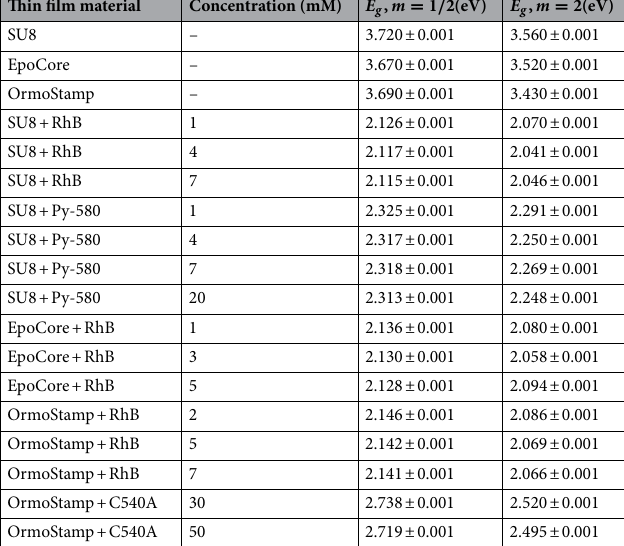
Table 3. Optical band gap obtained for polymeric thin film